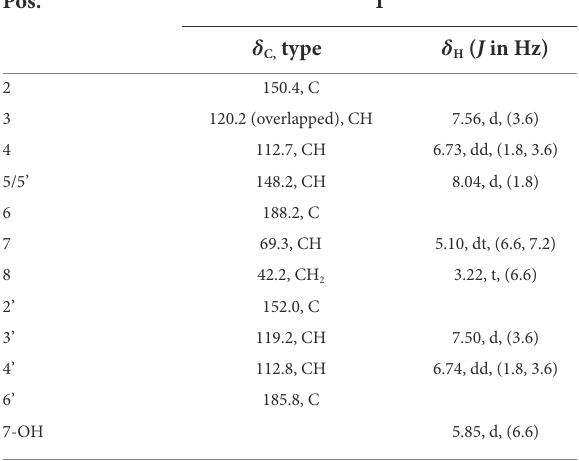
TABLE 1 1 H (600 MHz) and 13 C (150 MHz) NMR for 1 in DMSO- d 6 .